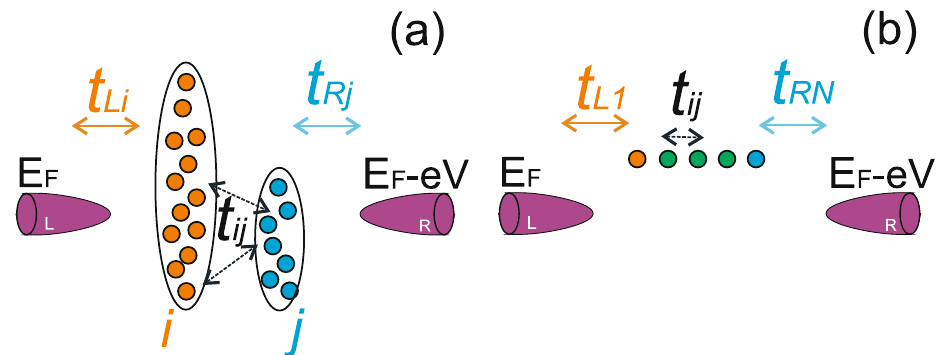
Figure 1. (Color online) Scheme of the tunneling contact with intermediate system formed by two clusters of impurity atoms (quantum dots). (a) General case of arbitrary intermediate system; (b) Intermediate chain-like